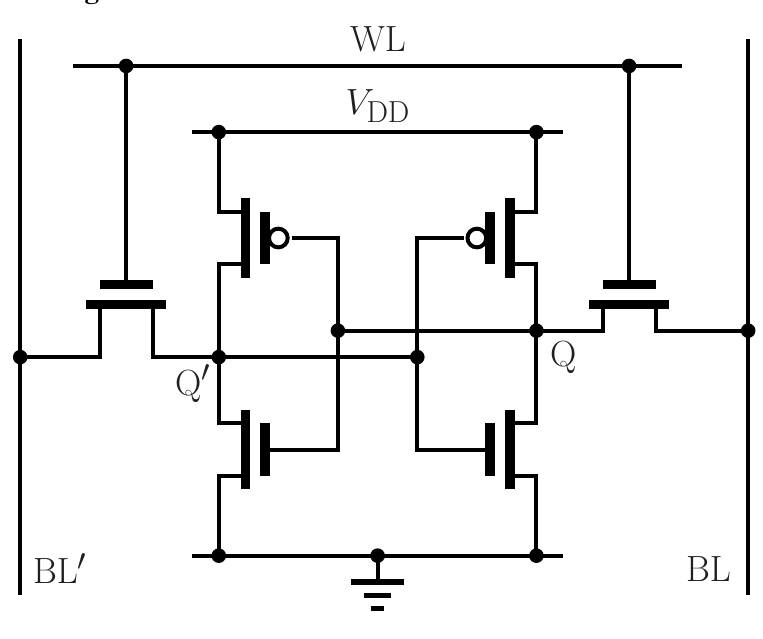
Figure 6. Variation of failure probability with σ ( V